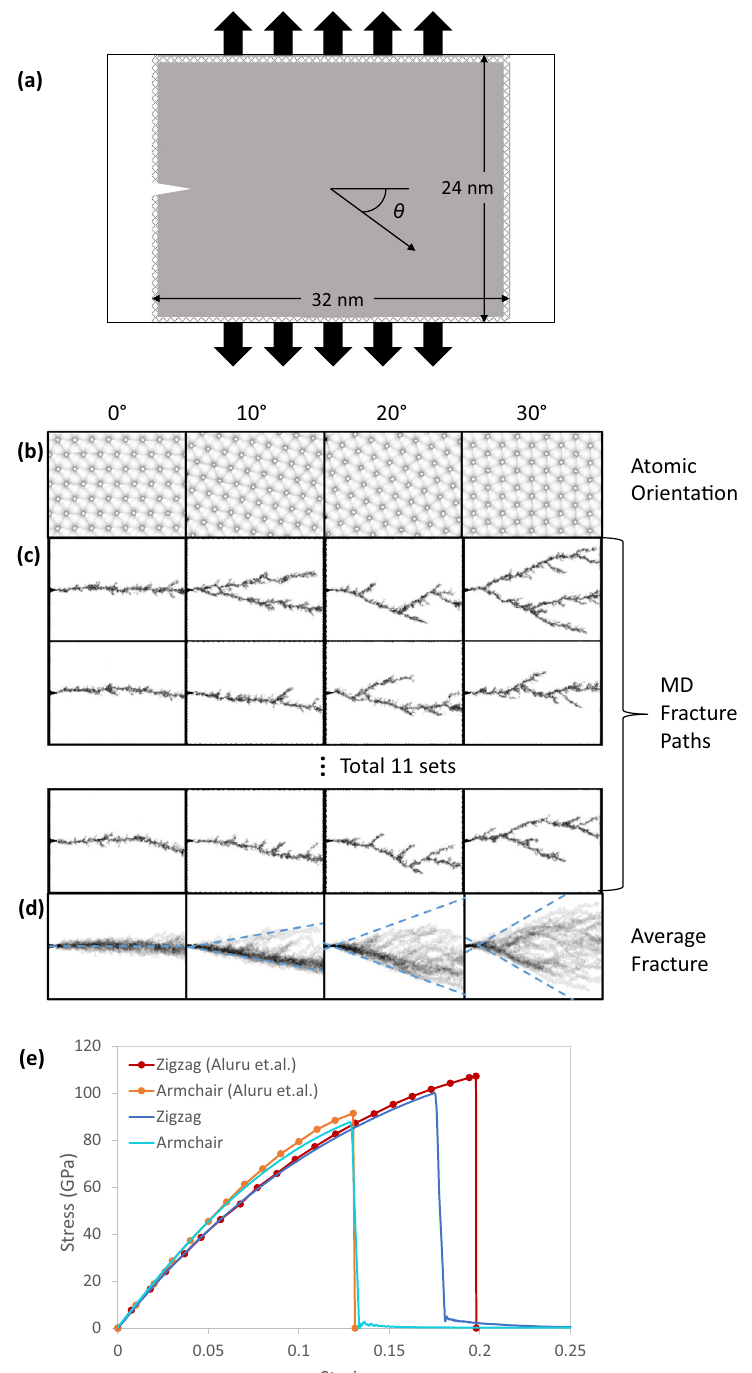
Fig. 1 MD studies of graphene fracture. a Graphene sample dimensions with periodic boundaries in only the tensile direction. The border atoms are restricted to only allow motion in the tensile direction. The fracture behavior of graphene was modeled across b four sheet orientations from armchair loading to zigzag loading. Each orientation was c fractured 11 separate times for a total for 44 samples. Averaging over each orientation illustrates fracture paths d fall within an envelope determined exactly by the rotation angle, biased toward fracture along zigzag edges. Stress – strain curves of e graphene fracture at both zigzag and armchair orientations show our MD results are nearly identical to previously published graphene crack simulations from Zhao et.al. 27 speci fi cally focusing on the orientation-dependent elastic properties of graphene under uniaxial model is given in Fig. 2a and further elaborated in “ Methods. ” Each fracture path image is split into segments of sequential input X [ t ] The 44 graphene fracture MD simulations are subsequently used and output y [ t ] matrix pairs in order to focus on the spatiotem- to train the ML model in capturing the complex orientation- poral relationship behind each step of crack propagation. By dependent fracture behavior of graphene. The structure of the ML